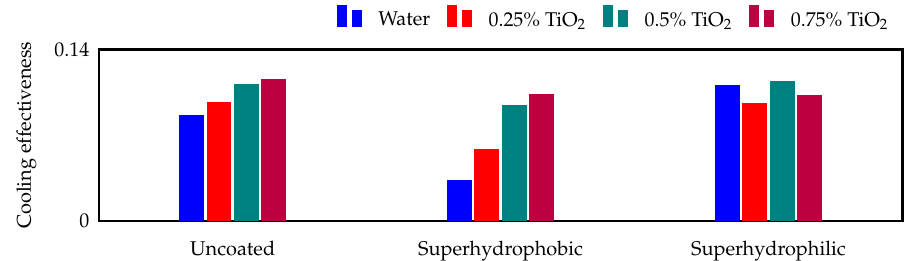
Figure 9. Cooling effectiveness for water and nanofluid droplets on different substrates. Nanoparticle concentration has a stronger impact on the cooling effectiveness for super-hydrophobic surfaces. Graph is reconstructed from [160].